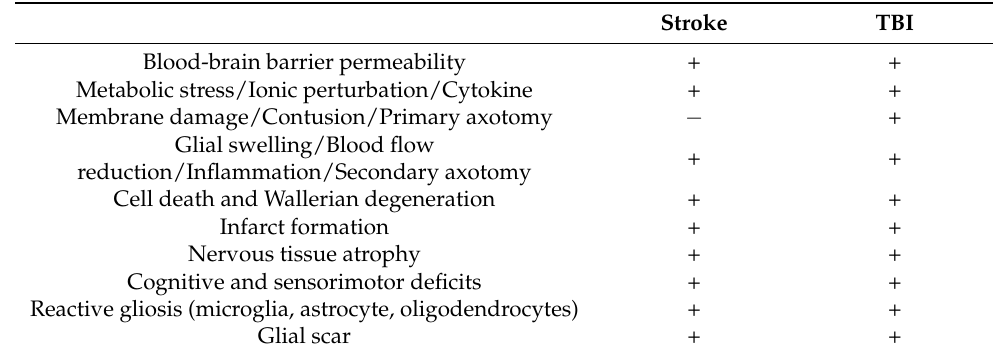
Table 2. Similarities of processes occurring in stroke and traumatic brain injury (TBI) in mammals. +: present; − : absent (adapted in part from the work of